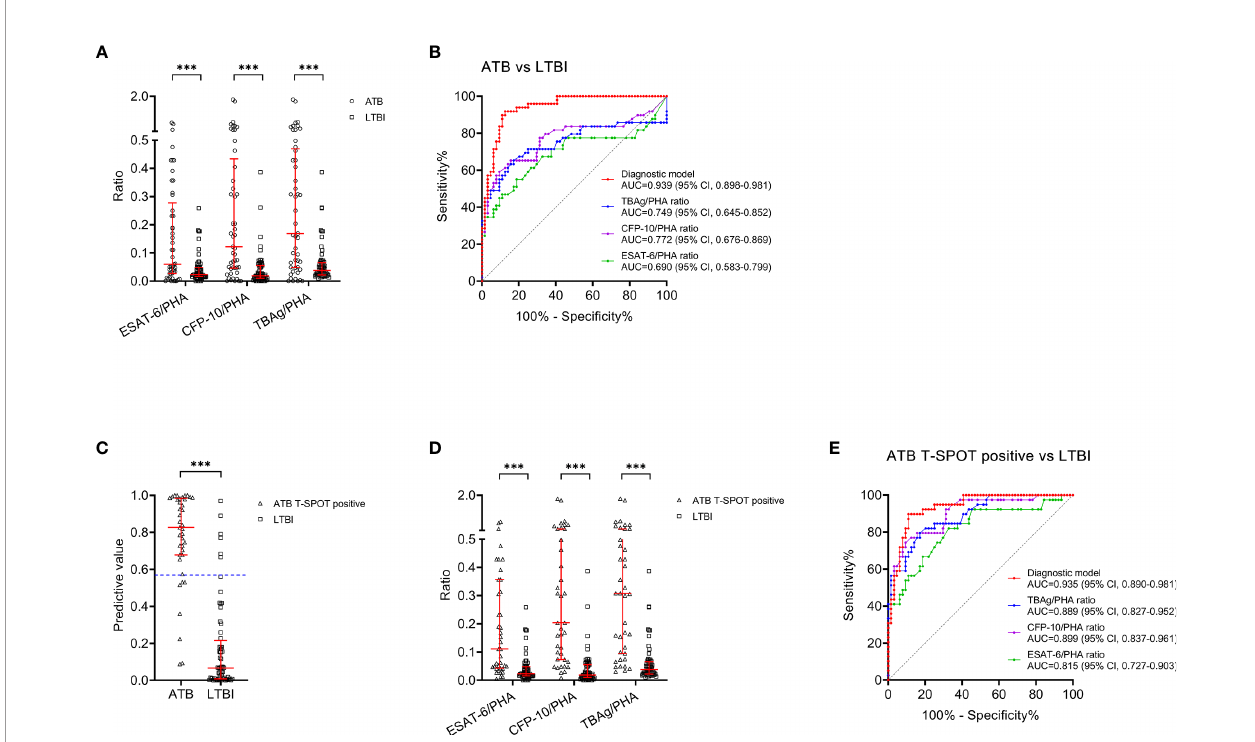
FIGURE 5 | Comparison between the diagnostic model and TBAg/PHA ratio for discriminating ATB from LTBI. (A) Scatter plots showing the values of ESAT-6/PHA ratio, CFP-10/PHA ratio, and TBAg/PHA ratio in ATB patients (n=49) and LTBI individuals (n=64). Bars indicated the medians and interquartile ranges. *** P < 0.001 (Mann-Whitney U test). (B) ROC analysis showing the performance of ESAT-6/PHA ratio, CFP-10/PHA ratio, TBAg/PHA ratio, and the diagnostic model in discriminating ATB patients from LTBI individuals. (C) Scatter plots showing the predictive value of diagnostic model in ATB patients with positive T-SPOT result (n=39) and LTBI individuals (n=64). Bars indicated the medians and interquartile ranges. *** P < 0.001 (Mann-Whitney U test). (D) Scatter plots showing the values of ESAT-6/PHA ratio, CFP-10/PHA ratio, and TBAg/PHA ratio in ATB patients with positive T-SPOT result (n=39) and LTBI individuals (n=64). Bars indicated the medians and interquartile ranges. *** P < 0.001 (Mann-Whitney U test). (E) ROC analysis showing the performance of ESAT-6/PHA ratio, CFP-10/PHA ratio, TBAg/ PHA ratio, and the diagnostic model in discriminating ATB patients with positive T-SPOT result from LTBI individuals. ESAT-6, early secreted antigenic target 6; CFP- 10, culture fi ltrate protein 10; PHA, phytohemagglutinin; TBAg, tuberculosis-speci fi c antigen; ATB, active tuberculosis; LTBI, latent tuberculosis infection; ROC, receiver operating characteristic; AUC, area under the curve; CI, con fi dence